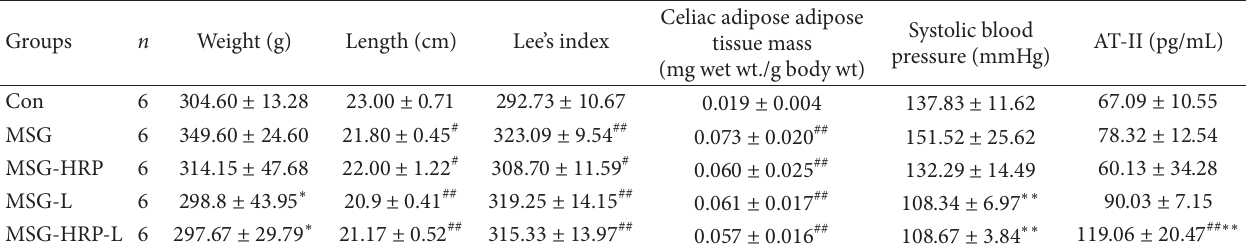
Figure 6: Fibrosis of the pancreatic islets ( × 400). Fibrosis of the pancreatic islets was significantly increased in MSG rats in the interior area of the islets compared with the Con group. The MSG rats, received HRP treatment had not improve status of islets fibrosis, whereas rats received losartan treatment ameliorate the fibrosis status. (a) Con; (b) MSG; (c) MSG-HRP; (d) MSG-L; (e) MSG-HRP-L. Table 1: Physiological and biochemical parameters of the study